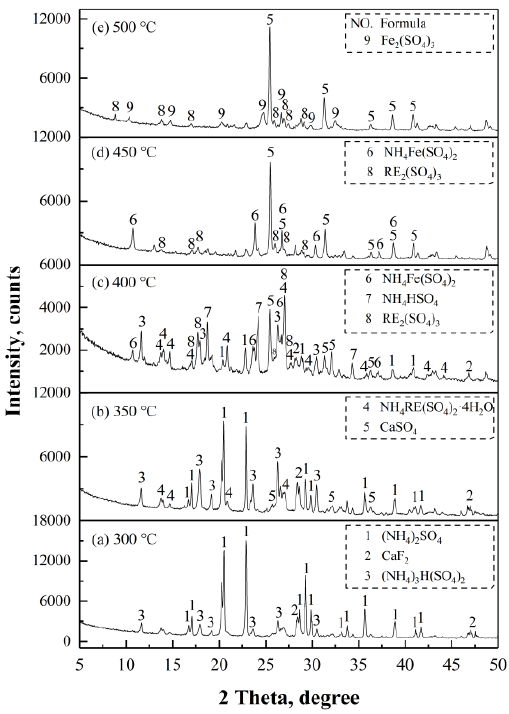
Figure 14. XRD patterns of (NH 4 ) 2 SO 4 activation roasting products at different temperatures: (a) 300 °C; (b) 350 °C; (c) 400 °C; (d) 450 °C; (e) 500 °C.